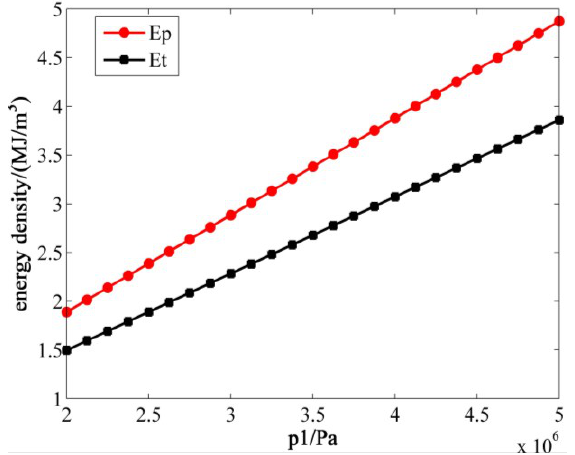
Figure 4. The variation of work density with pre-set pressure.